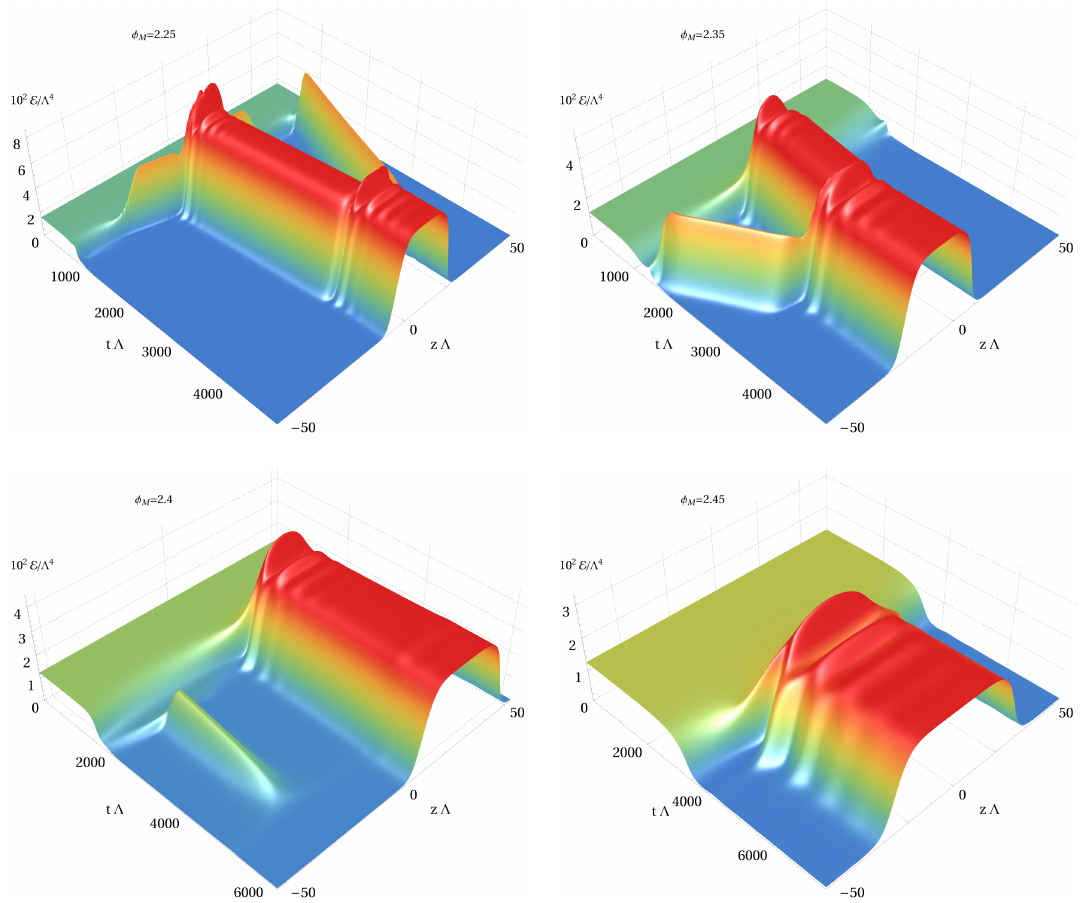
Figure 8 . Four spacetime evolution of the local energy density with a plateau formation for the subcritical theories from top left to bottom right with φ M = { 2 . 25 , 2 . 35 , 2 . 4 , 2 . 45 } , initial local energy density E ( t = 0) = {E 3 , E 2 , E 2 , E 2 } and same longitudinal extent L z Λ ≈ 107 , where the plateau forms before merger with peaks (top left and right) or the plateau forms with a peak dissipation (bottom left) or only directly a plateau reshapes (bottom